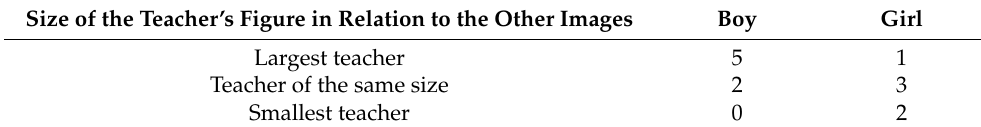
Table 1. Representation of the teacher.